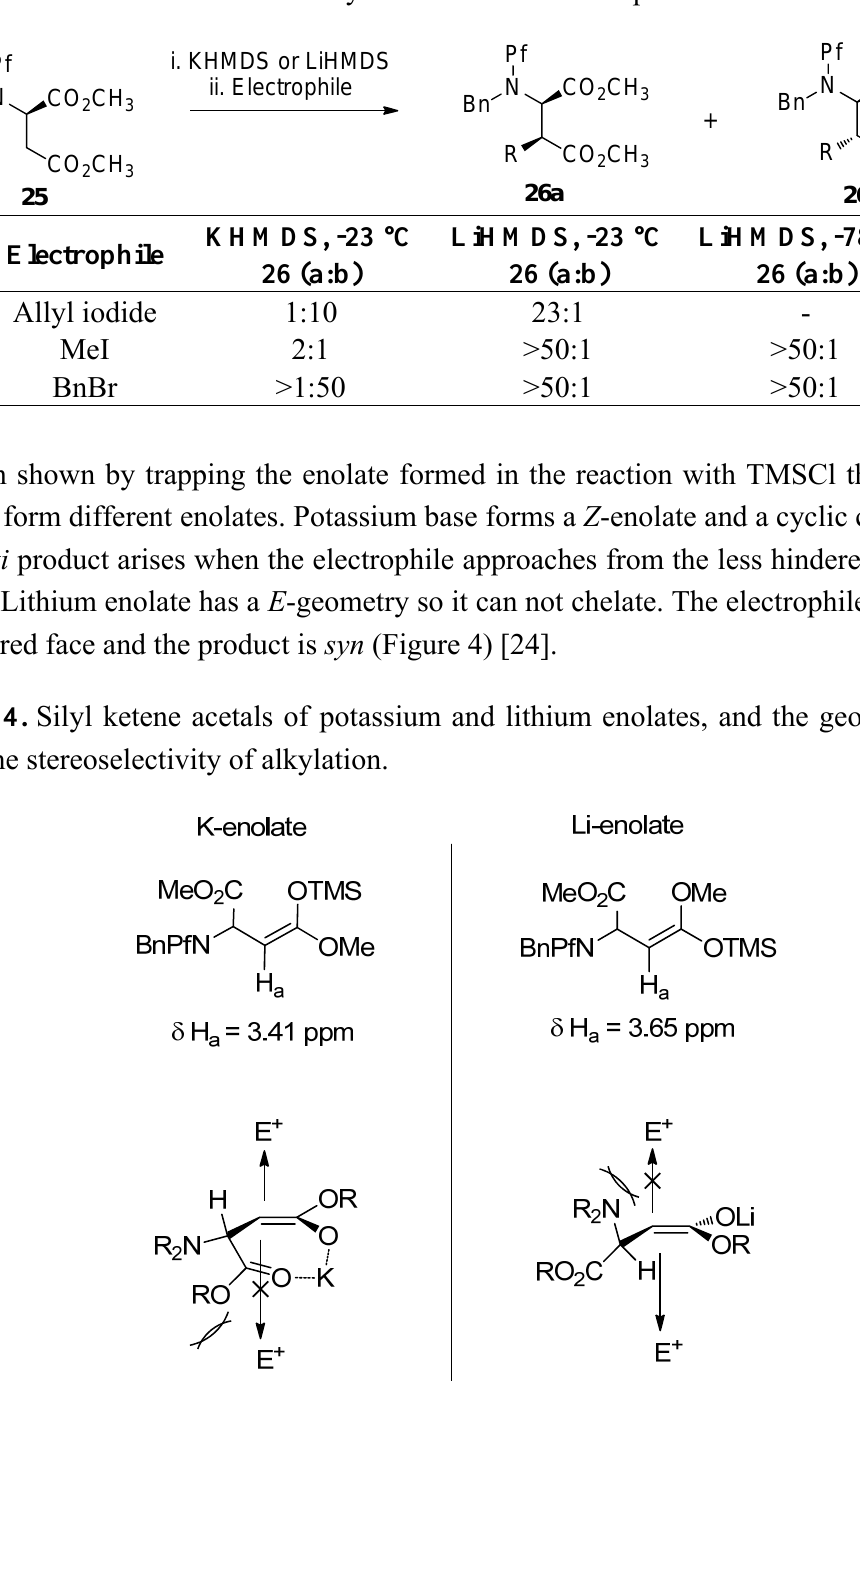
Table 2. Alkylation of N -Pf-Bn- D -aspartate.